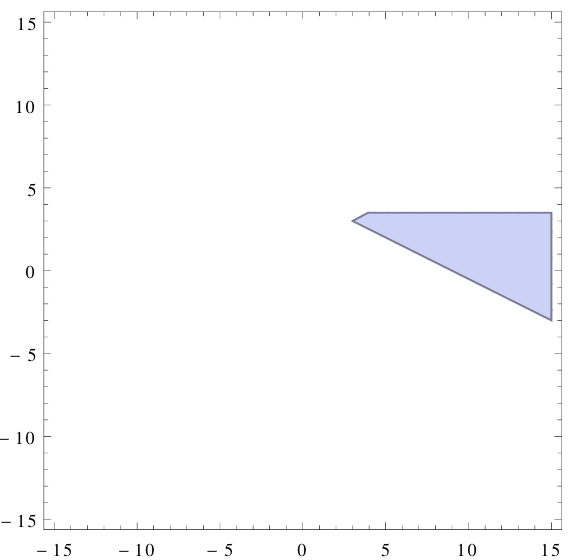
=V e(cid:11) and y (cid:17) V R =V e(cid:11) , the region extends inde(cid:12)nitely 4 6